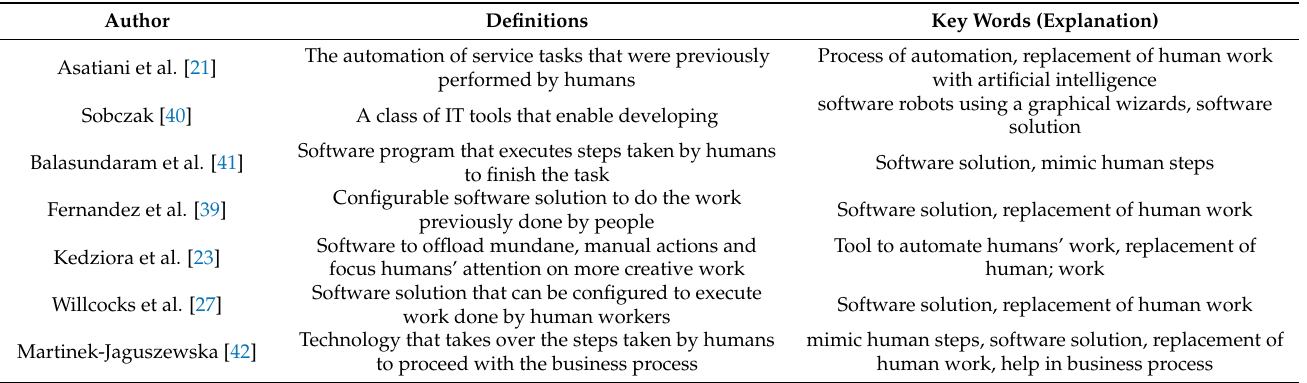
Table 1. Chosen RPA